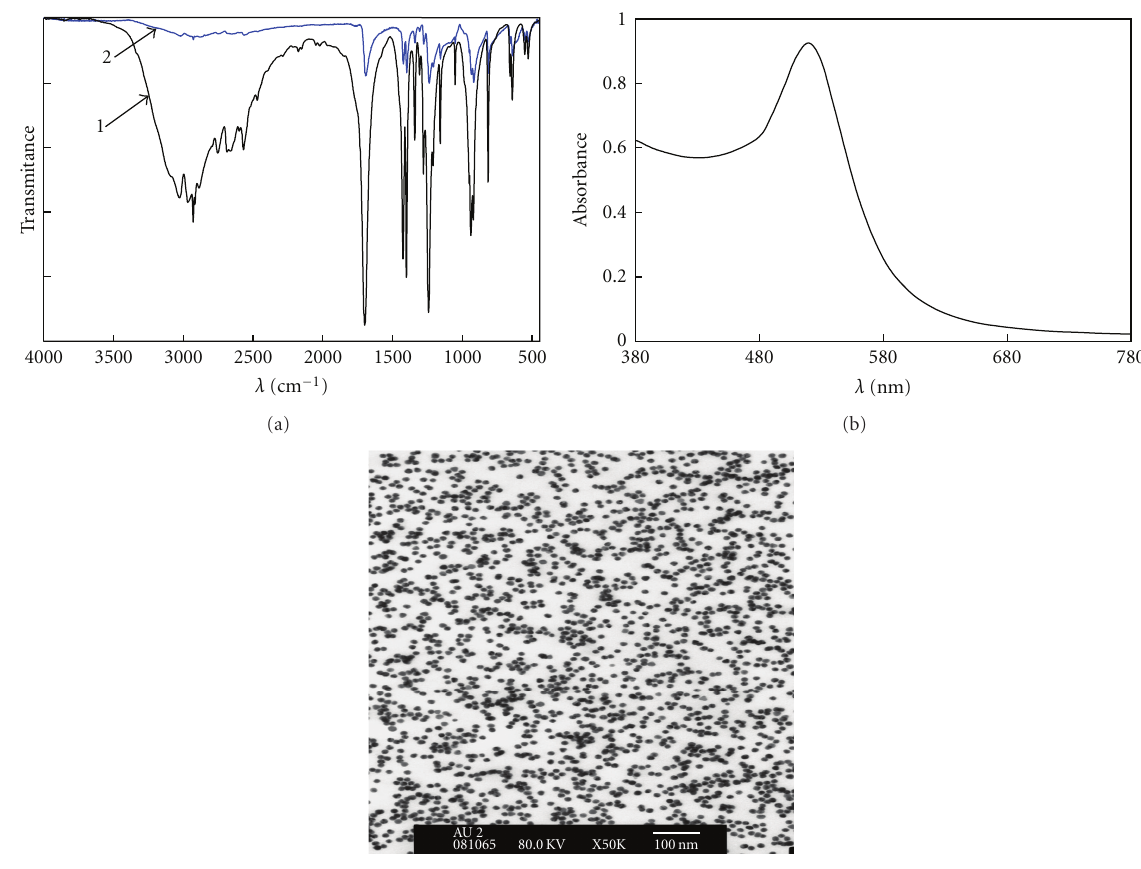
(c) Figure 1: (a) The transmission FT-IR spectra (1) the reflectance spectra of compounds adsorbed on the Au plate (2) and for DTDPA. (b) Optical UV-Vis spectrum of the colloidal Au solution. (c) Transmission electron image of the gold